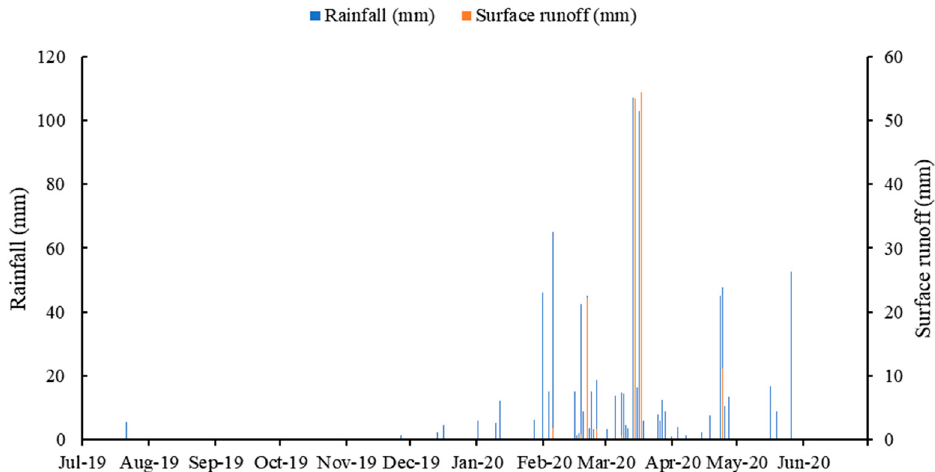
Figure 6. Rainfall and runoff events in the study period.